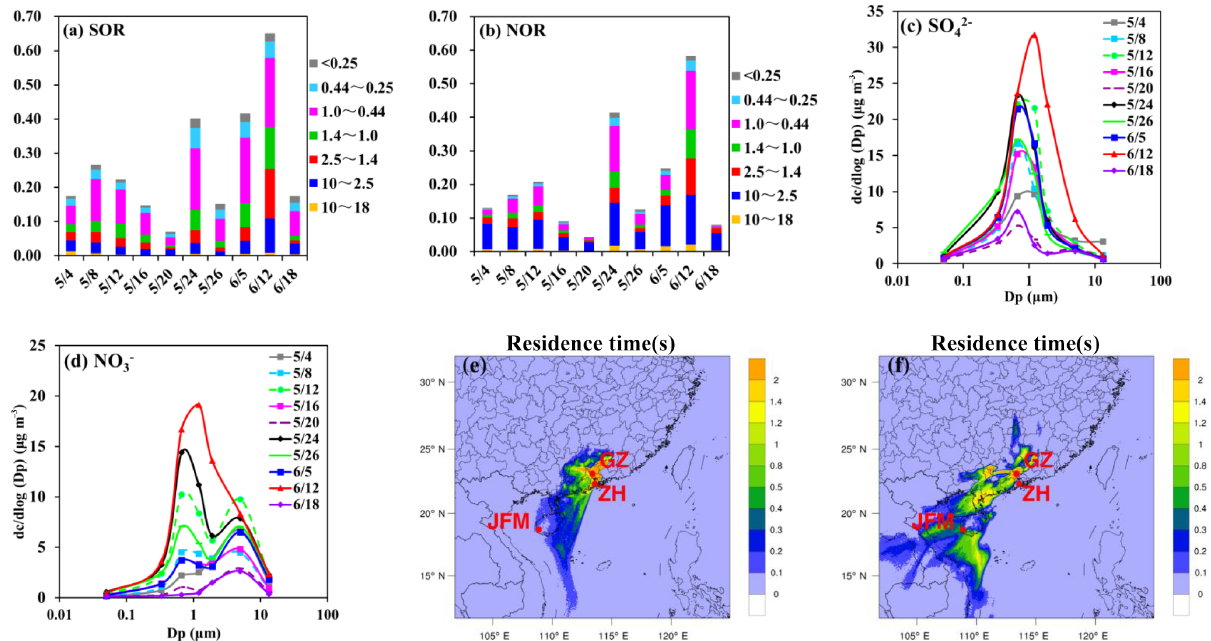
Figure 6. Case study on 12 June in GZ. (a–b) The time series of sulfur oxidation ratio (SOR) and nitrogen oxidation ratio (NOR). (c–d) The mass size distribution of SO 2 − and NO − . (e–f) FLEXPART–WRF total column residence times over the last 72h, arriving in GZ on 12 June 4 3 at 100 and